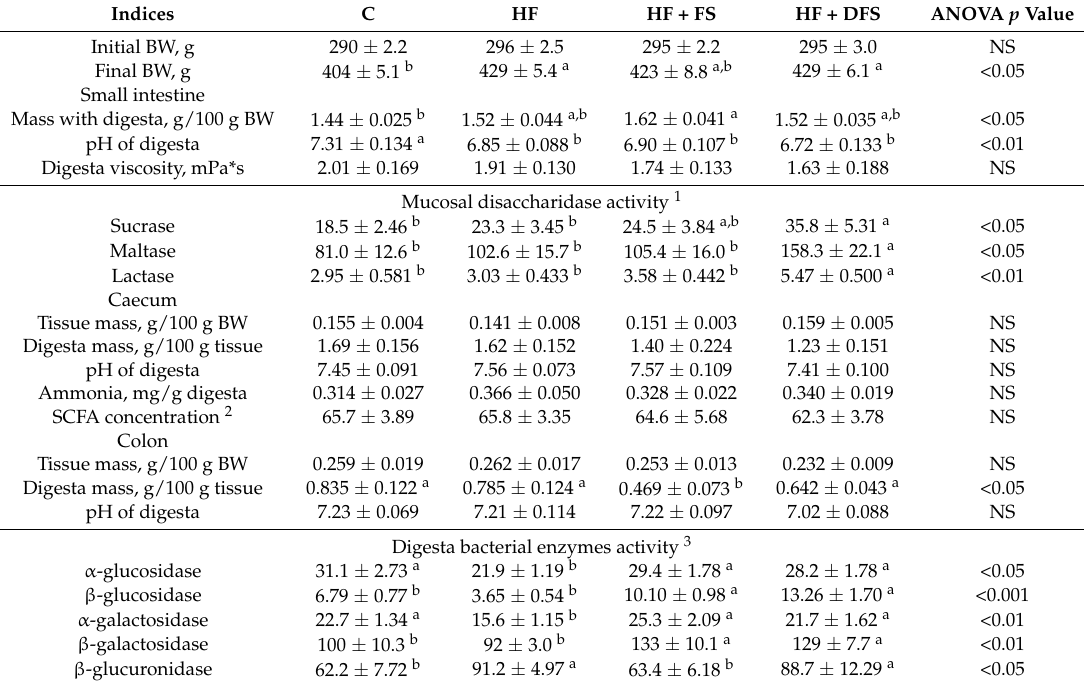
Table 2. Body weight and physiological indices of the gastrointestinal tract of rats.